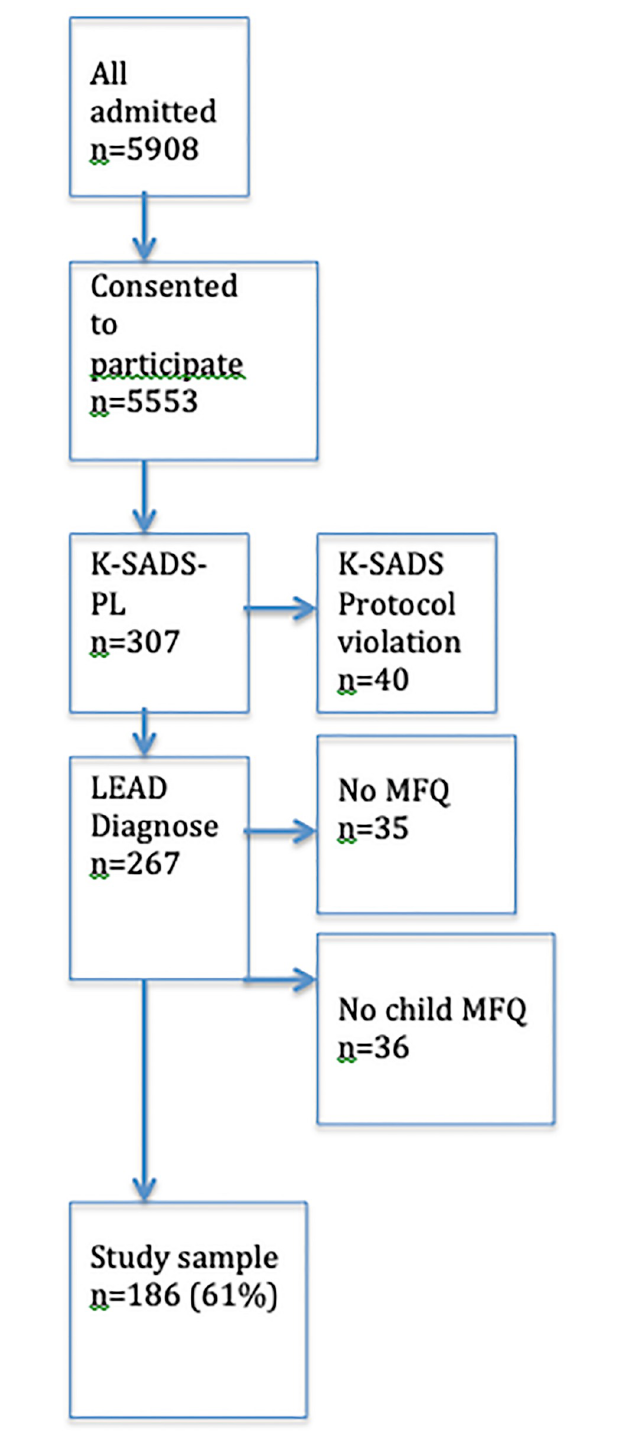
Fig 1. Flow chart of